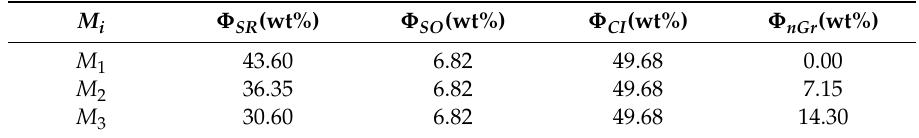
Table 2. Membrane volume fractions 1 .